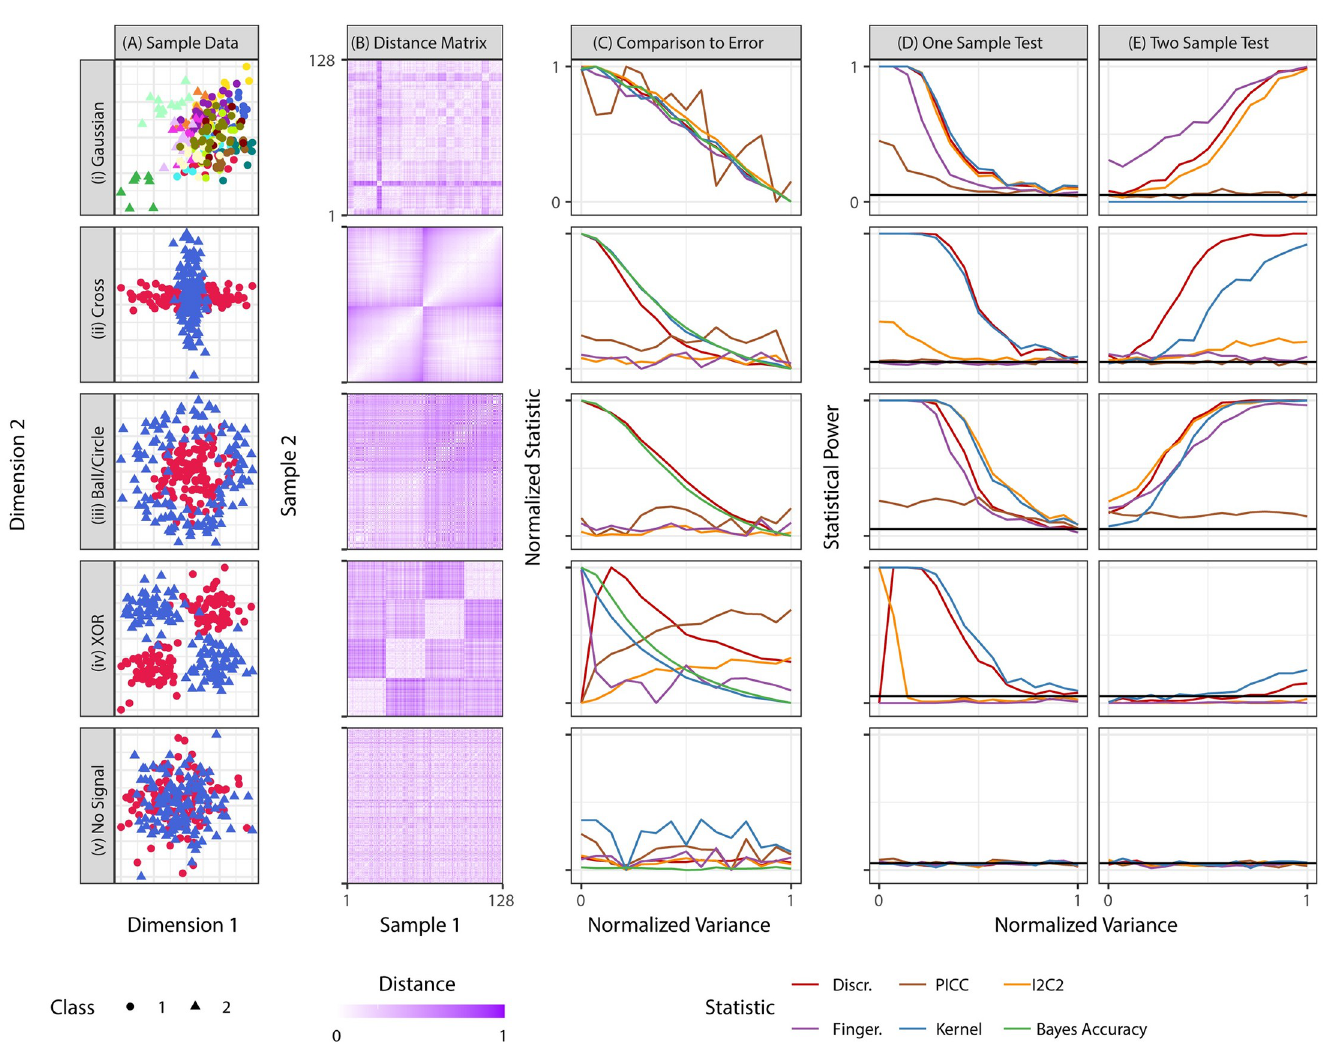
Fig 2. Multivariate simulations demonstrate the value of optimizing replicability for experimental design. All simulations are two-dimensional, with 128 samples, with 500 iterations per setting (see S4 Text for details). (A) For each setting, class label is indicated by shape, and color indicates item identity. (B) Euclidean distance matrix between samples within each simulation setting. Samples are organized by item. Simulation settings in which items are discriminable tend to have a block structure where samples from the same item are relatively similar to one another. (C) Replicability statistic versus variance. Here, we can compute the Bayes accuracy (the best one could perform to predict class label) as a function of variance. Discr and Kernel are mostly monotonic relative to within-item variance across all settings, suggesting that one can predict improved performance via improved Discr . (D) Test of whether data are discriminable. Discr typically achieves high power among the alternative statistics in all cases. (E) Comparison test of which approach is more discriminable. Discr is the only statistic which achieves high power in all settings in which any statistic was able to achieve high power.